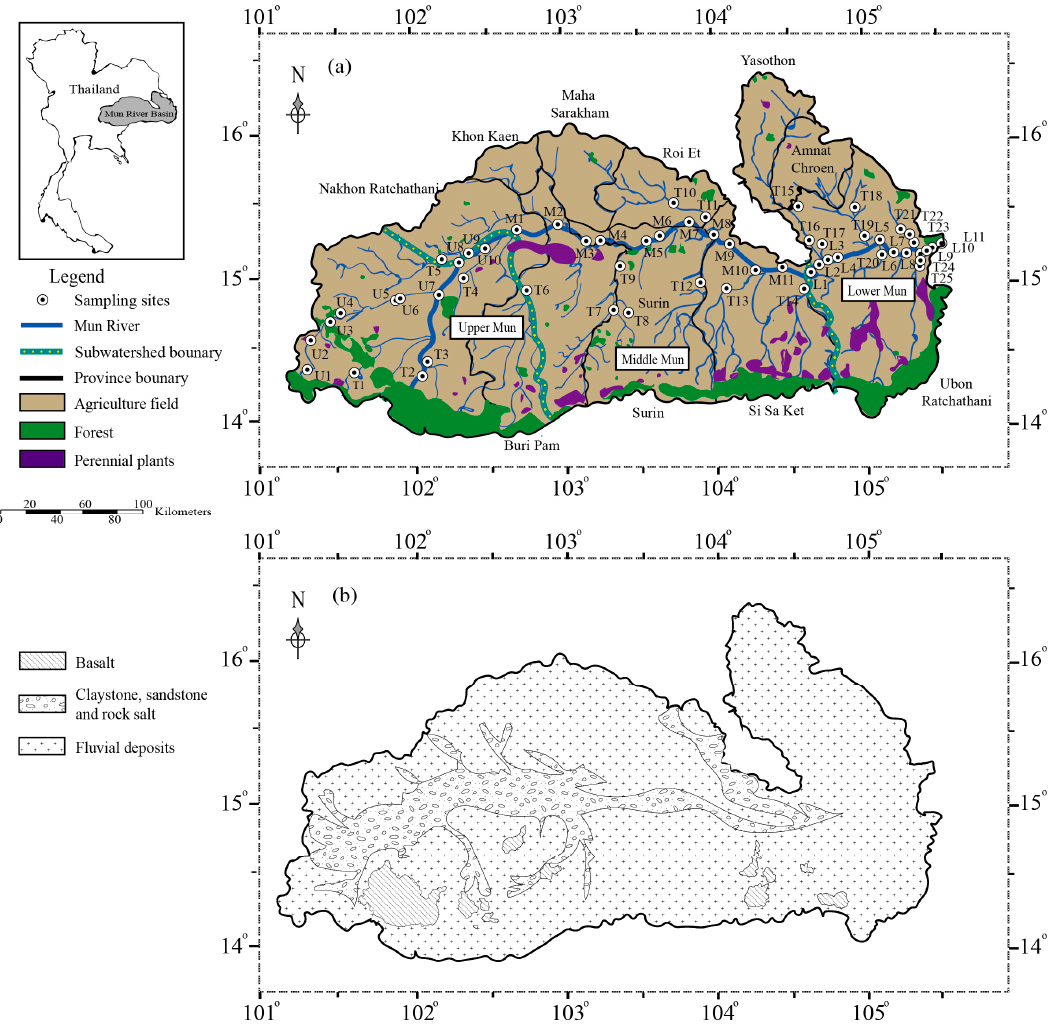
Figure 1. Geographic information of the Mun River Basin: ( a ) distribution of sampling sites and land-use types; ( b ) lithological characteristics.